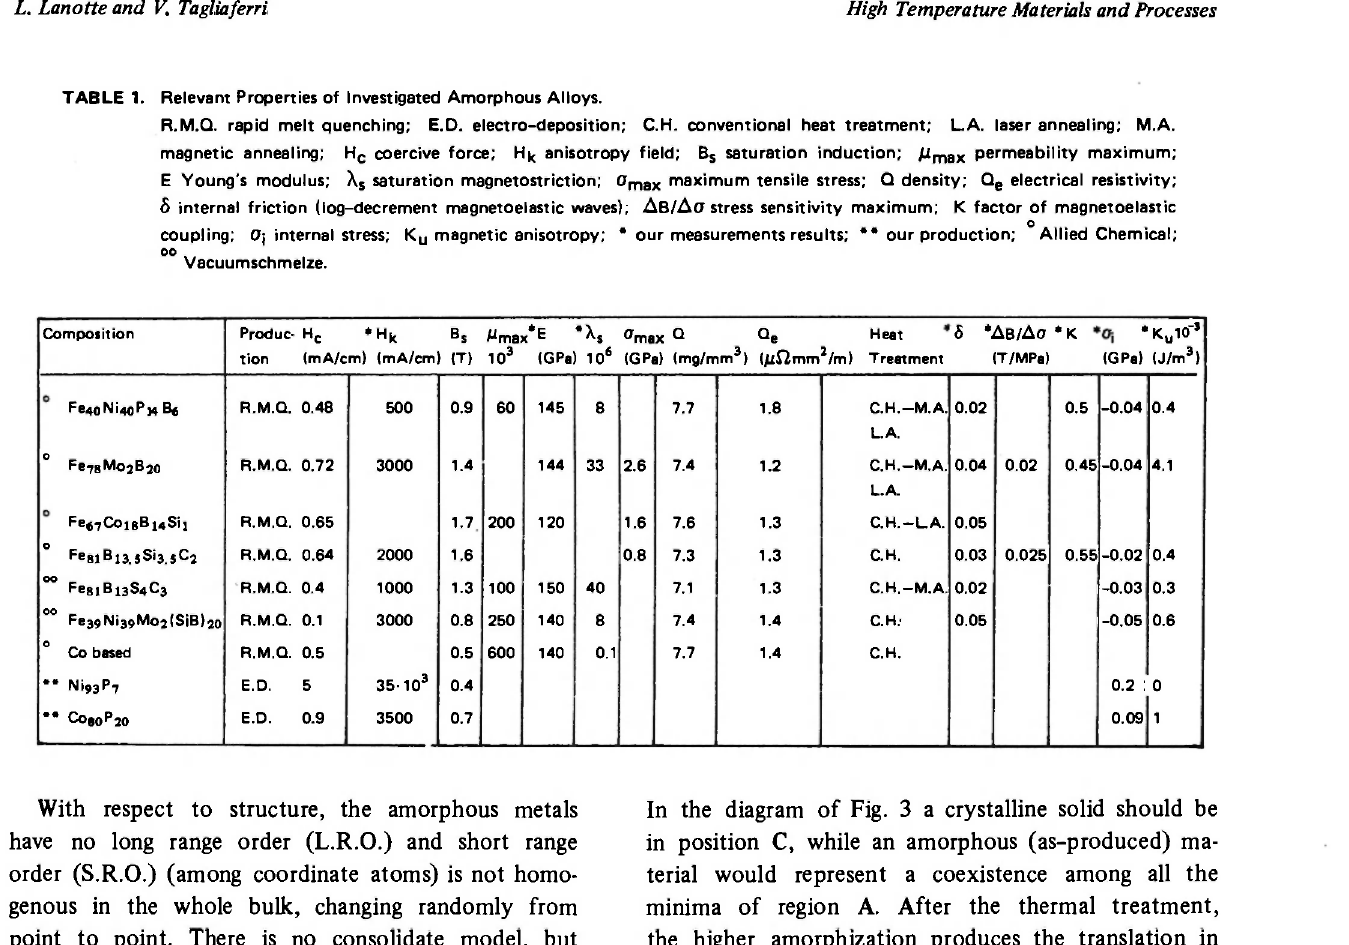
TABLE 1. Relevant Properties of Investigated Amorphous Alloys. R.M.Q. rapid melt quenching; E.D. electro-deposition; C.H. conventional heat treatment; L.A. laser annealing; M.A. magnetic annealing; H c coercive force; H^ anisotropy field; B s saturation induction; Al max permeability maximum; Ε Young's modulus; X s saturation magnetostriction; (7 max maximum tensile stress; Q density; Q e electrical resistivity; δ internal friction (log-decrement magnetoelastic waves); Δβ/Αα stress sensitivity maximum; Κ factor of magnetoelastic coupling; Oj internal stress; K u magnetic anisotropy; * our measurements results; ** our production; Allied Chemical; 00 Vacuumschmelze.